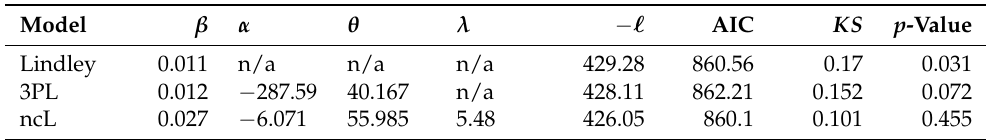
Table 3. Estimated parameters and goodness of fit statistics of considered models for the guinea pigs